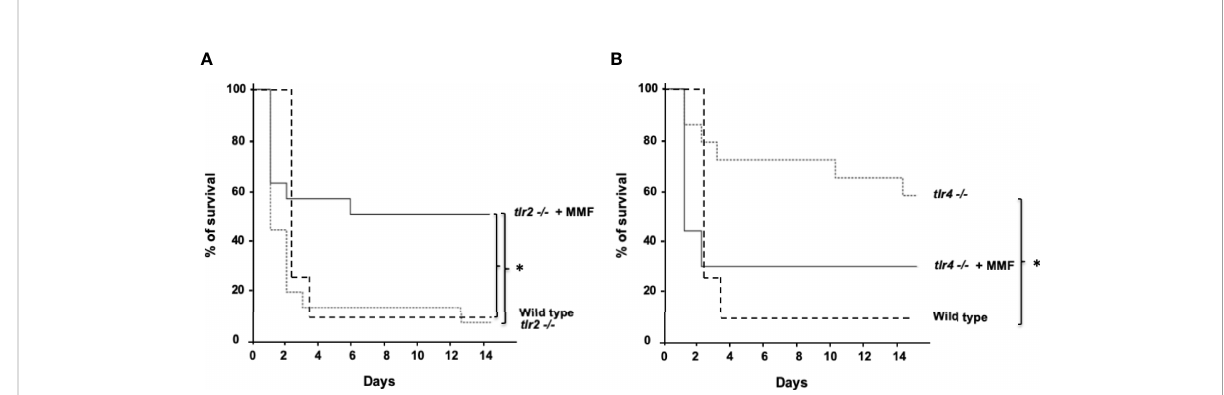
FIGURE 6 MMF improves survival during i.p. S. aureus infection in Tlr2(-/-) mice (A) but not in Tlr4(-/-) mice (B) Tlr2(-/-) and Tlr4(-/-) mice were treated with MMF, which started one day before i.p. injection of 10 8 CFU S. aureus and for 3 more days (dashed line, n=17 and n=15, respectively, representing 4 experiments) and were compared to Tlr2(-/-) and Tlr4(-/-) control mice (Dotted line, n=17 and n=15 respectively, representing 4 experiments) and with wild type control mice treated with an equivalent volume of NaCl 0.9% (n=25, representing the 8 experiments). Survival was monitored for 14 days after infection. *Log-rank test, P <0.01.